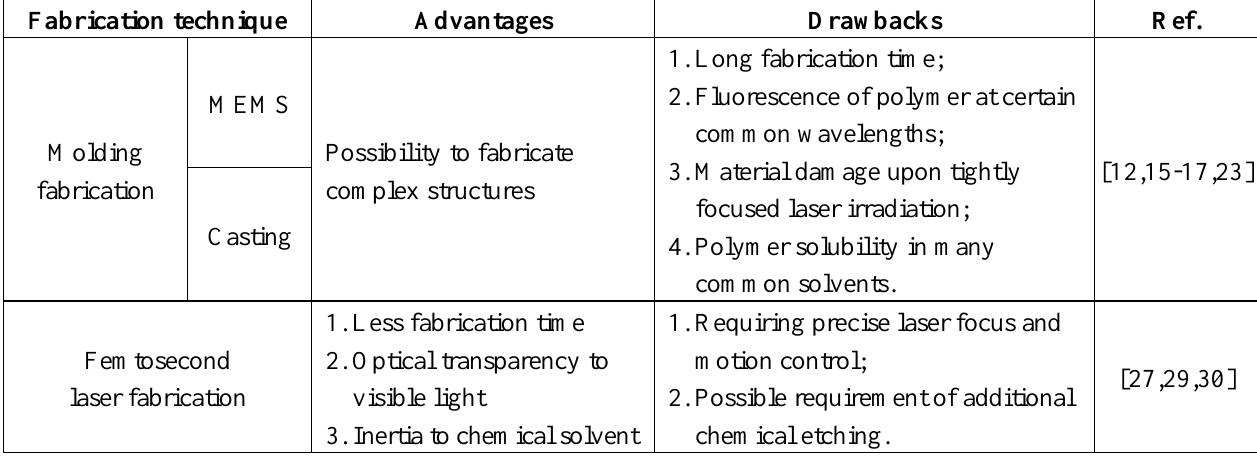
Table 4. Comparison of the advantages and drawbacks of different fabrication techniques. Fabrication